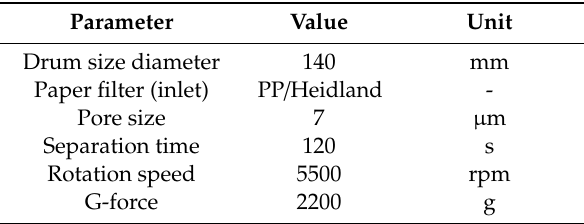
Table 1. Parameters of solid–liquid separation by centrifugation used for the laboratory test (lab